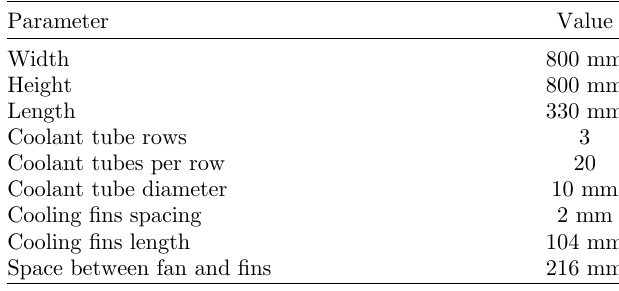
Table 2. Key characteristics of the heat